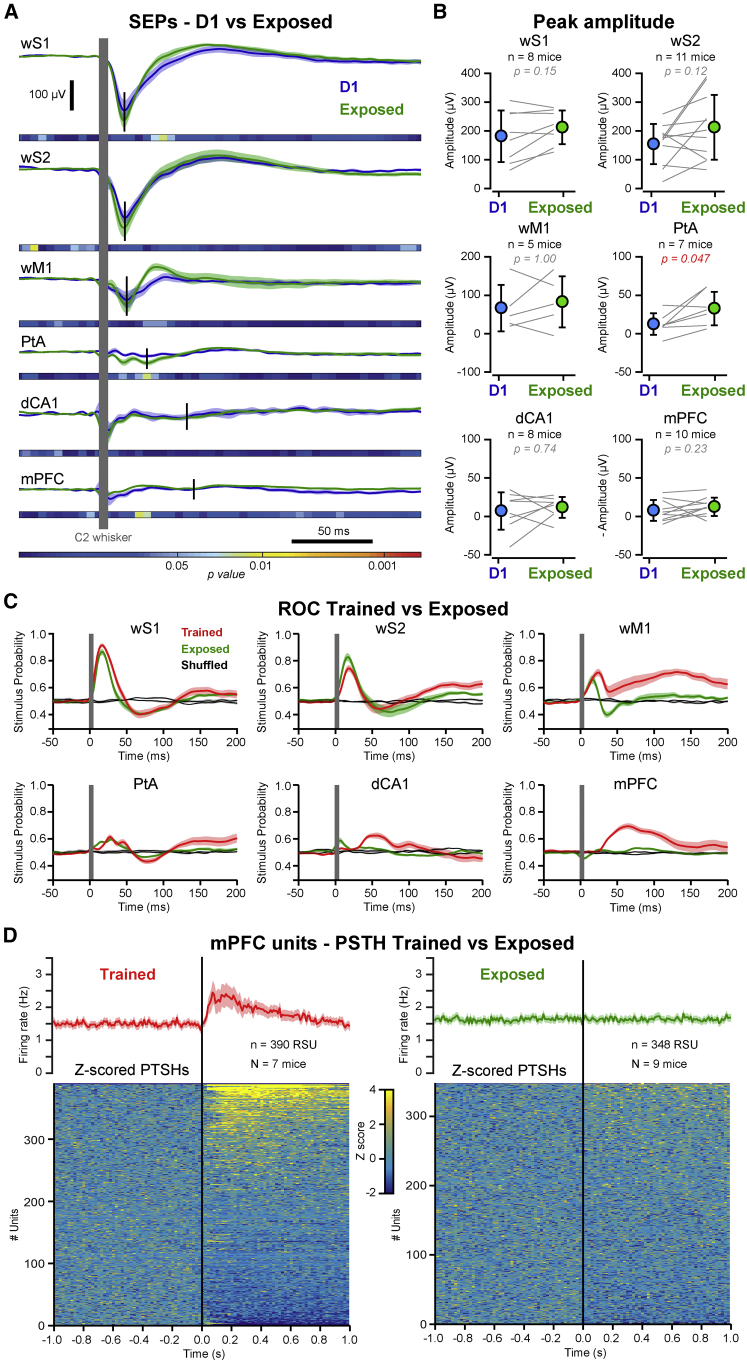
Task-Specific Development of the Sensory-Evoked Responses in dCA1 and mPFC(A) Grand average SEPs computed for all whisker stimuli, on the first day (D1, blue) and after 5–10 days of neutral exposure (Exposed, green) for the same mice. Shaded areas indicate SEM. Horizontal bars indicate color-coded p values for statistical test of the difference between D1 and Exposed conditions across time (Wilcoxon signed-rank test, D1 versus Exposed for 5 ms time windows). Vertical black bars indicate the times of the peak responses.(B) Comparison of the peak amplitude of the SEPs for D1 (blue) and Exposed (green) conditions. Circles with bars indicate mean ± SD. Gray lines represent individual mice. The red p value indicates a statistically significant difference between D1 and Exposed (Wilcoxon signed-rank test).(C) Receiver operating characteristic (ROC) analysis. Average performance (mean ± SEM) of a classifier in decoding the stimulus probability from LFP activity in each area recorded in mice trained in the detection task (Trained, red) and in mice after neutral exposure (Exposed, green). Black lines with gray shading indicate performance of the classifier for label-shuffled distributions.(D) Top: grand average PSTHs computed for all whisker stimuli from 390 RSUs recorded in the mPFC of mice trained in the detection task (red, N = 7 mice) and from 348 RSUs recorded in the mPFC of mice after neutral exposure (green, N = 9 mice). Shaded areas indicate SEM. Bottom: Z scored PSTHs for the RSUs recorded in mice trained in the detection task (left) and the RSUs recorded in mice after neutral exposure (right). PSTHs are sorted according to change in firing rate after whisker stimulus.